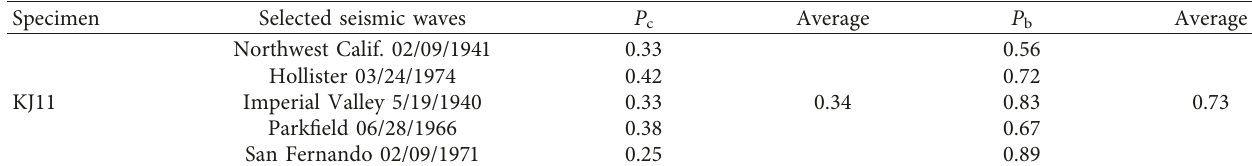
Table 23: Plastic hinge rates of beams and columns in model KJ11.